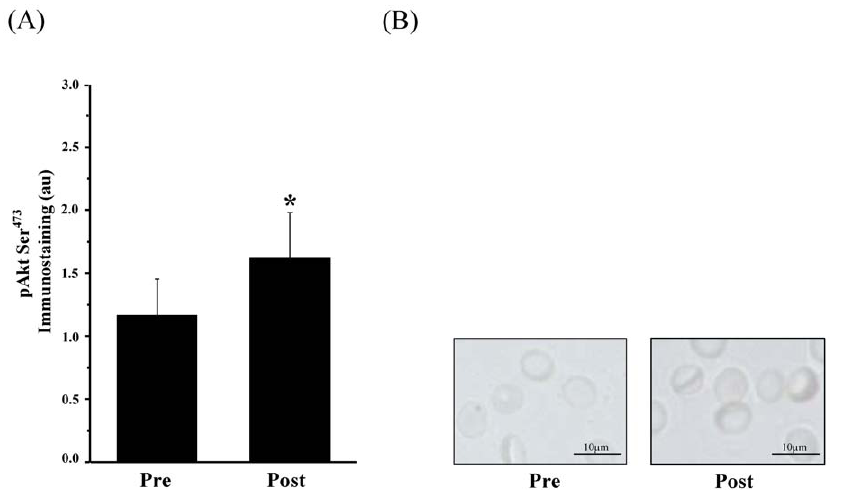
Figure 1. Change in phosphoAktSer 473 before (Pre) and after (Post) AMRT determined by immunohistochemistry. (A) Bars show statistical analysis of gray values (au) between Pre and Post condition. The phosphoAktSer 473 signal in human RBCs significantly increased from Pre to Post ( P , 0.05). (B) Pictures show representative phosphoAktSer 473 staining before and after the test, respectively. Magnification for all images was 400-fold. Data in (A) are presented as mean 6 S.E.M of